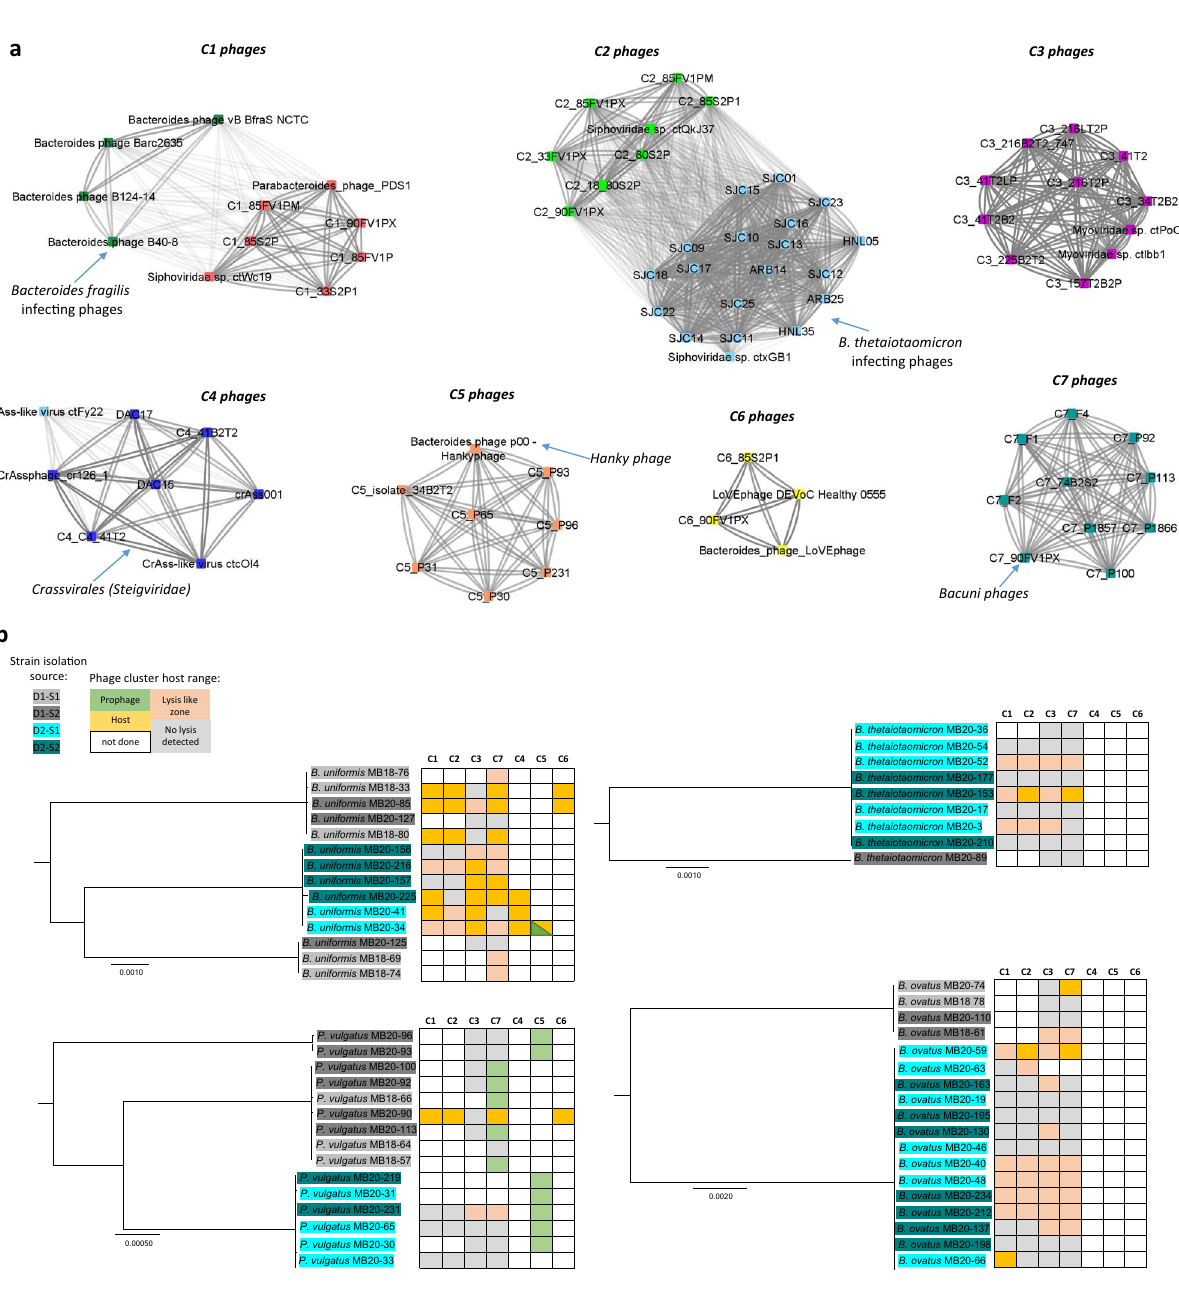
Figure 3. The phages isolated in this study belong to seven distinct clusters and have broad host-range. ( a ) Network taxonomic classification of isolated phage genomes, using the ViralRefSeq-prokaryotes-v94 database and known isolated Bacteroides -infecting phages from the literature. Only phages isolated in this study and phages related to the isolated clusters are presented. The phages are colored according to vConTACT2 cluster affiliation which corresponds to ICTV genus. Phages isolated in this study have names beginning with cluster name (C1, C2…) and prophages of C5 and C7 groups are indicated by P immediately following cluster designation. The complete output is available in Supplementary File 6. ( b ) Visualization of phage cluster host range on B. uniformis, P. vulgatus, B. thetaiotaomicron, and B. ovatus strains shown as phylogenetic trees based on core-genome alignment. Strains isolated from D1 and D2 are highlighted in grey and blue, respectively. Host ranges of C1, C2, C3, and C7 phages were tested with plaque and spot assays. For the explanation of lysis-like zone, please see text. For groups C4 and C5 no plaques were obtained but phages were detected using NGS sequencing in liquid cultures. Although amenable to plaque assay, no pure phage lysate could be obtained for C6, so no spot assays were done. The C5 and C7 prophages were detected using genomic